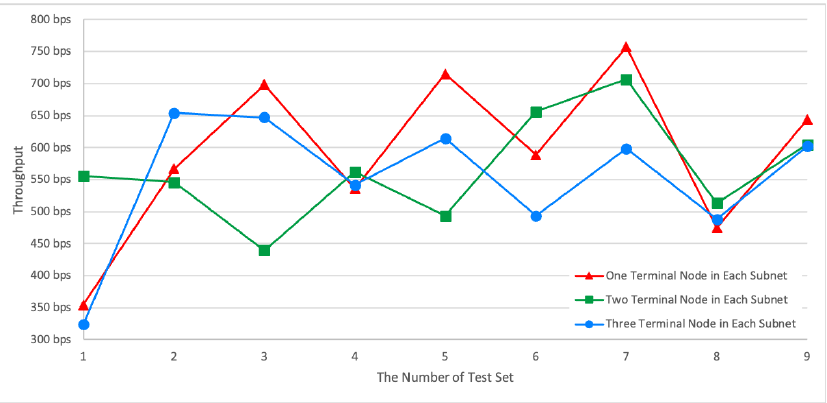
Figure 13. The records of the throughput field